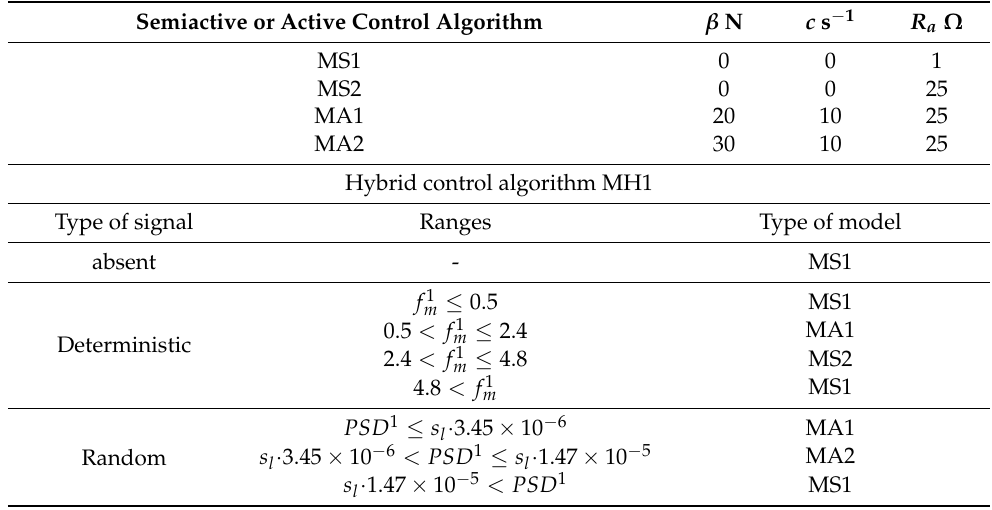
Table 4. Parameters of the proposed control